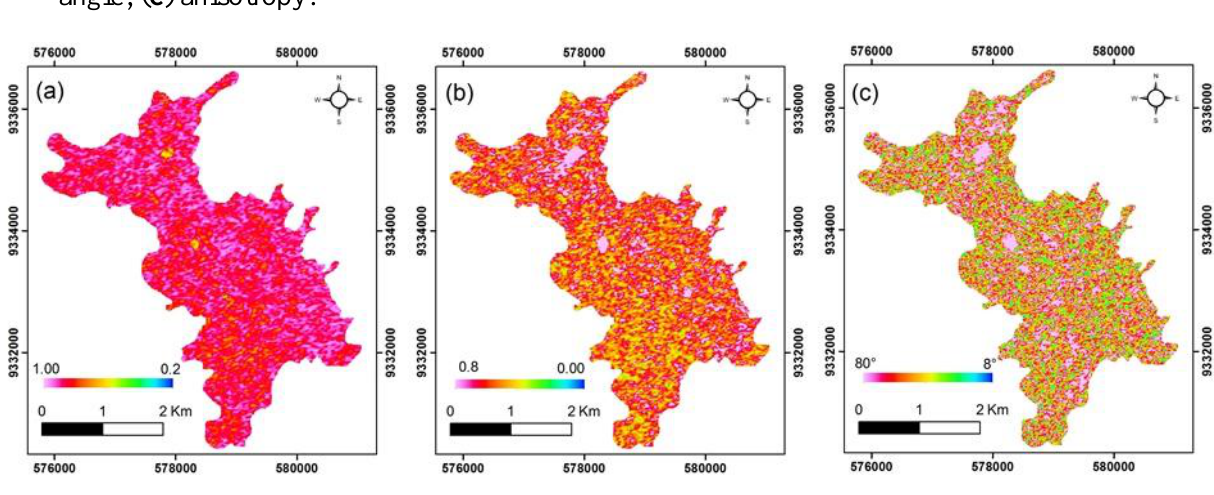
Figure 5. Images resulting from the parameters derived from the eigenvector-eigenvalue decomposition model applied to the RADARSAT-2 image: ( a ) entropy; ( b ) mean alpha angle; ( c ) anisotropy.